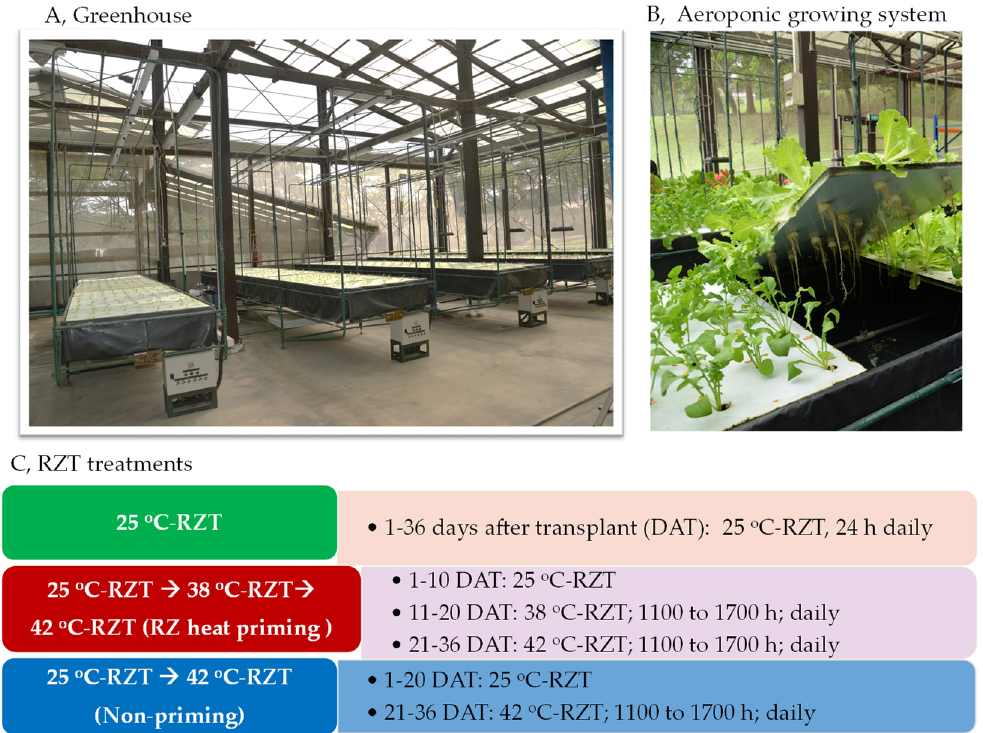
Figure 8. Photos of the tropical greenhouse ( A ) and aeroponic growing system ( B ) and different RZT treatments ( C ).